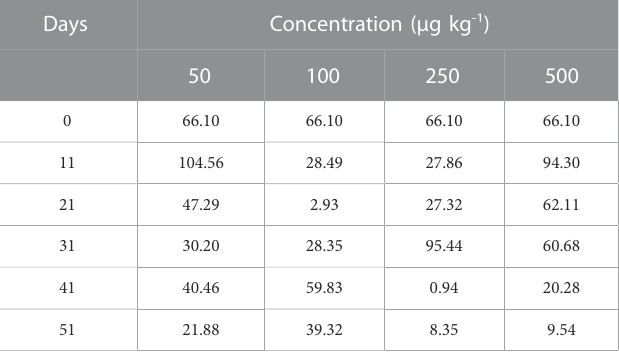
TABLE 5 Recovery percentage (R %) of EB metabolite Emamectin B 1b .